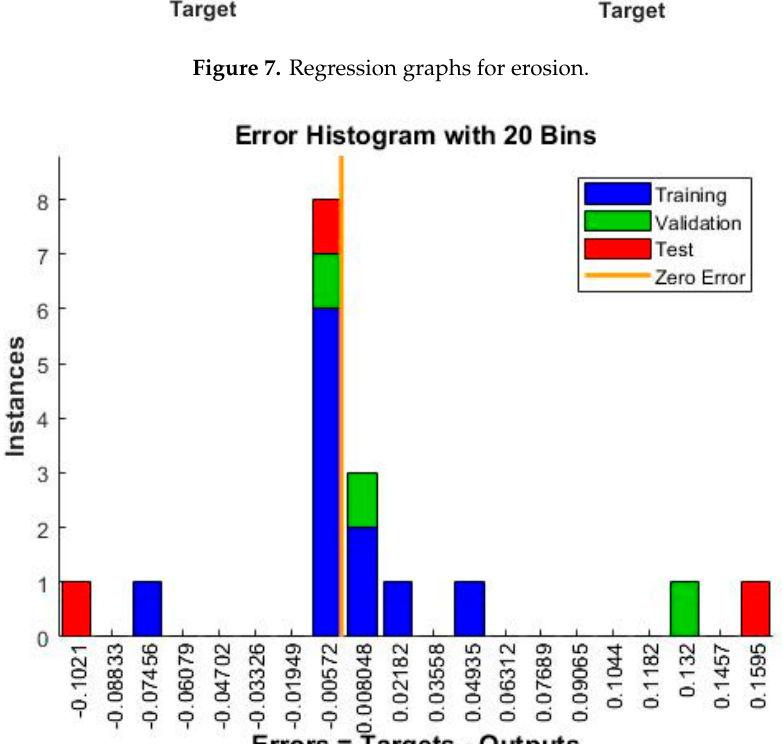
Figure 8. Error histogram chart.